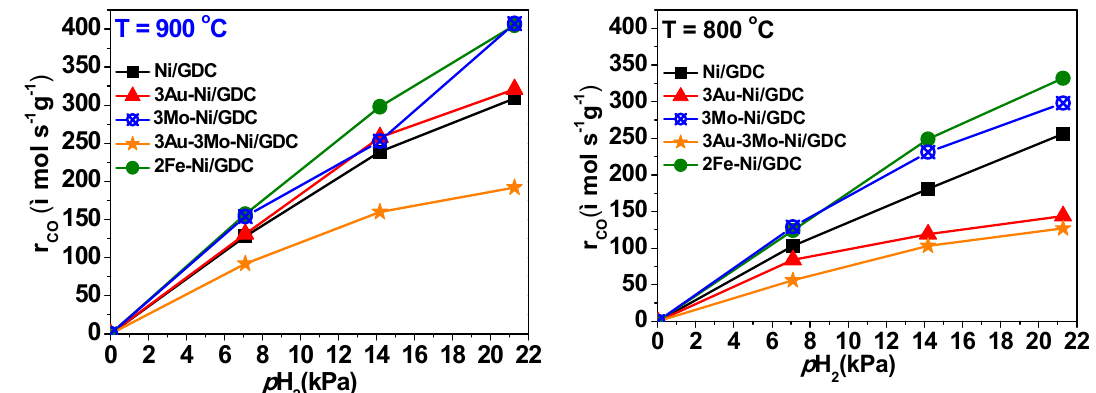
Figure 7. Steady state effect of the H 2 partial pressure (pH 2 , kPa) on the CO production rates ( μ mol ( µ mol s − 1 g − 1 ) on ESCs comprising: Ni/GDC, 3Au-Ni/GDC, 3Mo-Ni/GDC, 3Au–3Mo-Ni/GDC, s − 1 g − 1 ) on ESCs comprising: Ni/GDC, 3Au- Ν i/GDC, 3 Μο - Ν i/GDC, 3Au–3 Μο - Ν i/GDC, and 2Fe- and 2Fe-Ni/GDC, for 900 ◦ C and 800 ◦ C. The pH 2 O/pCO 2 ratios are fixed and their values Ni/GDC, for 900 °C and 800 °C. The pH 2 O/pCO 2 ratios are fixed and their values are presented in